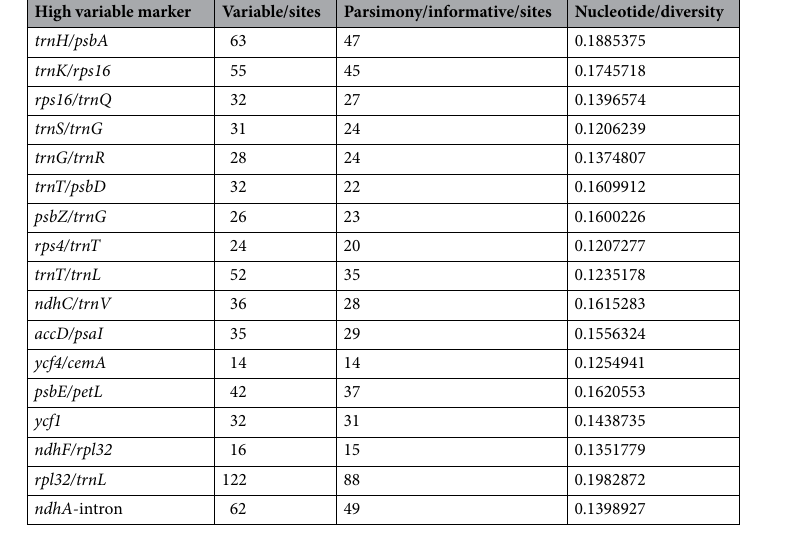
Table 4. High variable marker of cp genomes among 23 Ulmaceae